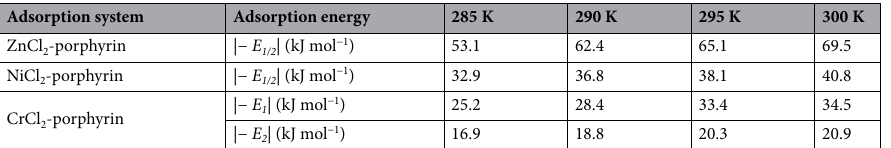
Table 6. Values of the adsorption energies |− E 1/2 | for zinc and nickel adsorptions and |− E 1 | and |− E 2 | for chromium adsorption given in modulus values at 285, 290, 295 and 300